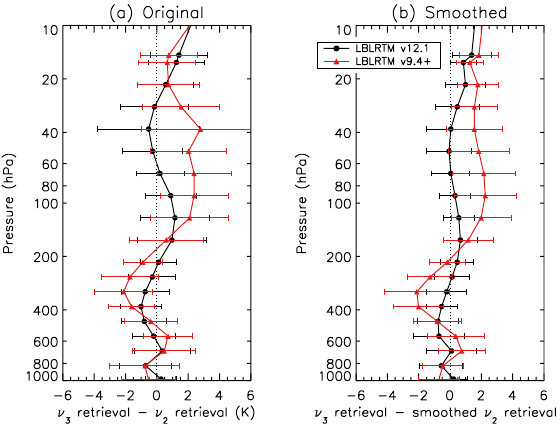
Fig. 12. Mean (solid line) and standard deviation (error bars) of the differences between the 120 temperature profiles retrieved with the ν 3 band of CO 2 and the profile retrieved with the ν 2 retrieval. (a) The mean differences between the original profiles. (b) The mean differences between the profiles after the ν 2 retrieval was smoothed using the averaging kernel of the ν 3 retrieval, as described in the text.